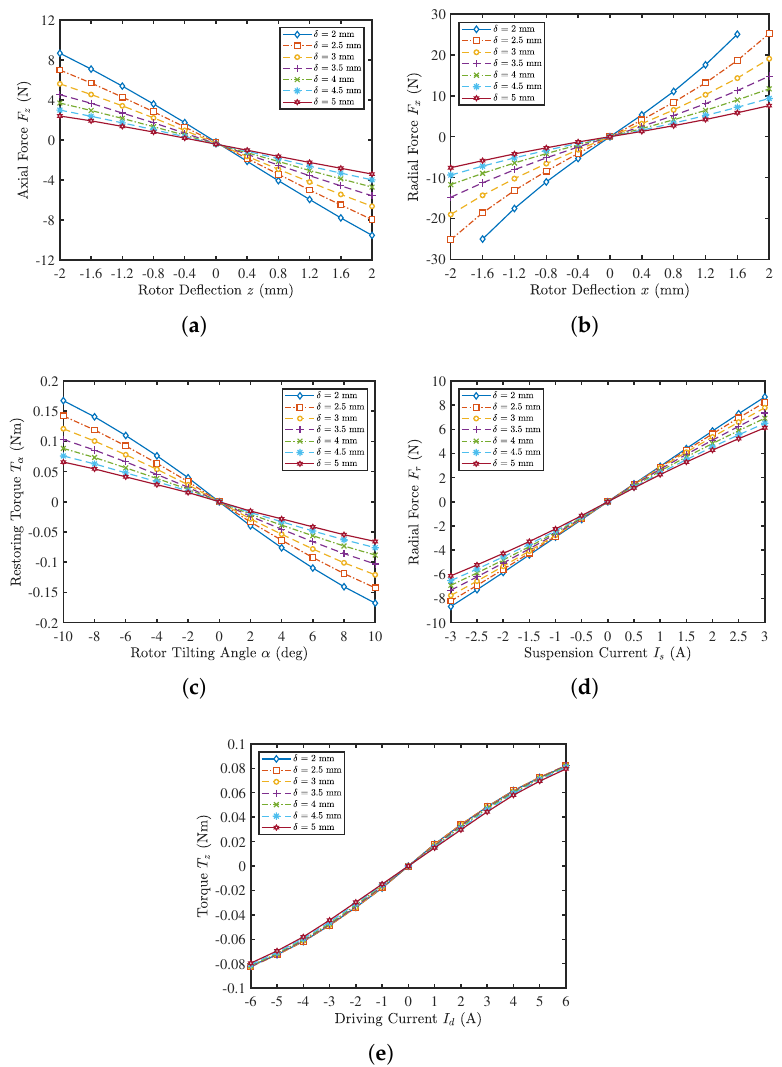
Figure 10. Three-dimensional FEM simulation results for different magnetic gap lengths δ . ( a ) Axial reluctance force for a rotor deflection in the z -direction. ( b ) Radial destabilizing force for a rotor deflection in the x -direction. ( c ) Restoring torque for a rotor tilting around the axis perpendicular to the direction of magnetization. ( d ) Active radial force for an applied suspension current. ( e ) Active torque for an applied drive